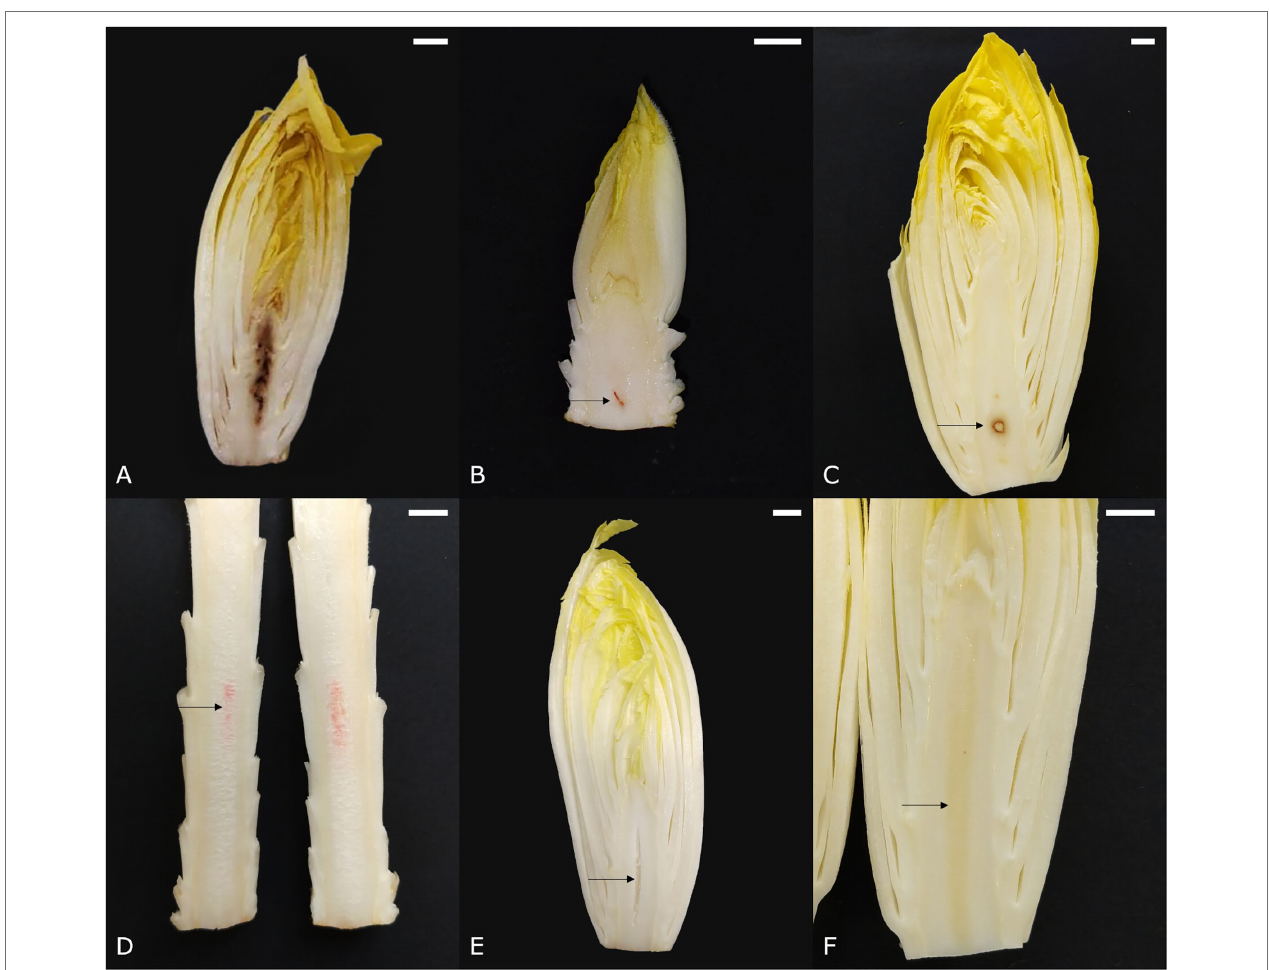
Leaf Edge Browning Chicons with brown edges on the external leaves are encountered rather frequently and symptoms can range from a few brown spots near the edge in the middle of the leaf ( Figure 3A ) to completely brown and necrotic leaf edges ( Figure 3B ). This color disorder is usually seen on cultivars with thin outer leaves and develops predominantly postharvest